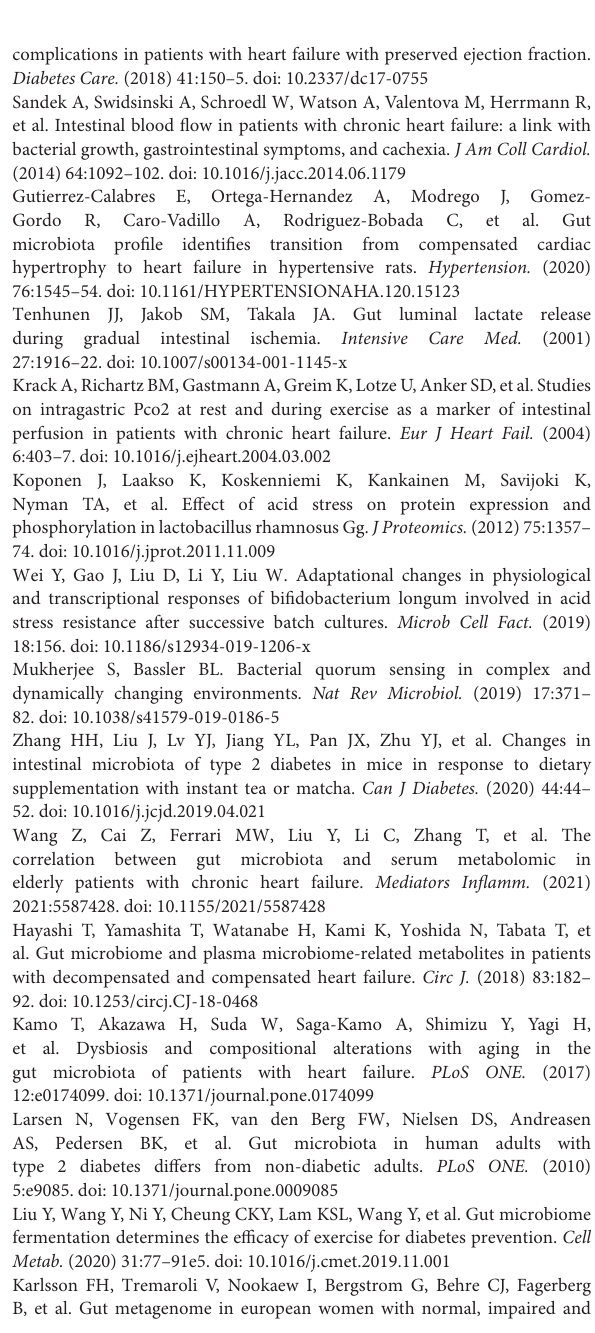
Supplementary Figure 3 | Fecal microbiota transplantation (FMT) did not change the morphometry and function of the cardiac tissue. (A,B) Cardiac size and cardiac fibrosis. (C) Ejection fraction (EF). (D) Left ventricular posterior wall dimensions at end-diastole (LVPWd). (E) Left ventricular internal diameter diastole (LVIDd). (F) Serum brain natriuretic peptide (BNP) levels. (G) Relative heart weight. (H) BW. n = 6. Supplementary Figure 4 | The predicted functions of the shared upregulated metabolism in fecal and serum samples. (A) . Shared upregulated metabolism in fecal and serum samples. (B) L-Glutamic acid enrichment pathway. (C) Noradrenaline. (D) Serotonin. Left, fecal; right,